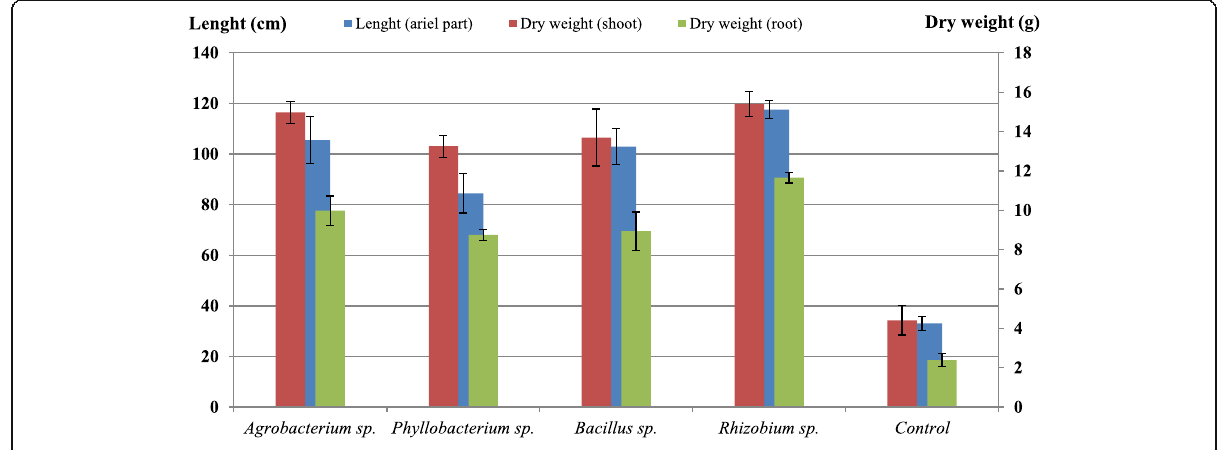
Fig. 5 Effect of inoculation with rhizobacterial strains on Acacia sp. growth